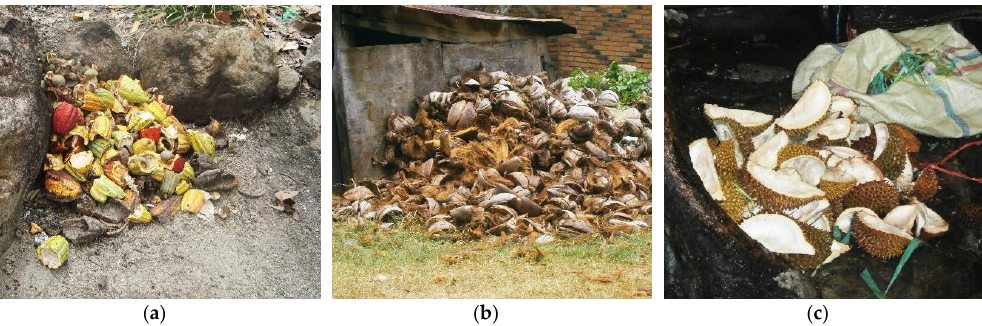
Figure 1. Unused fruit waste biomass in Laguboti district, North Sumatra (Republic of Indonesia): ( a ) cacao fruit skins, ( b ) coconut fruit skins, and ( c ) durian fruit skins.